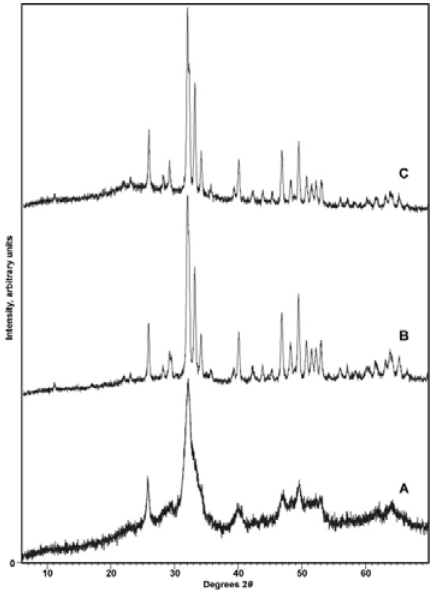
Figure 10. XRD patterns for CCaApOH containing 12.8 wt% carbonate; ( A ) after in vacuo drying; ( B ) after dehydration at 550 °C; and ( C ) after rehydration for 4 days at 100 °C.